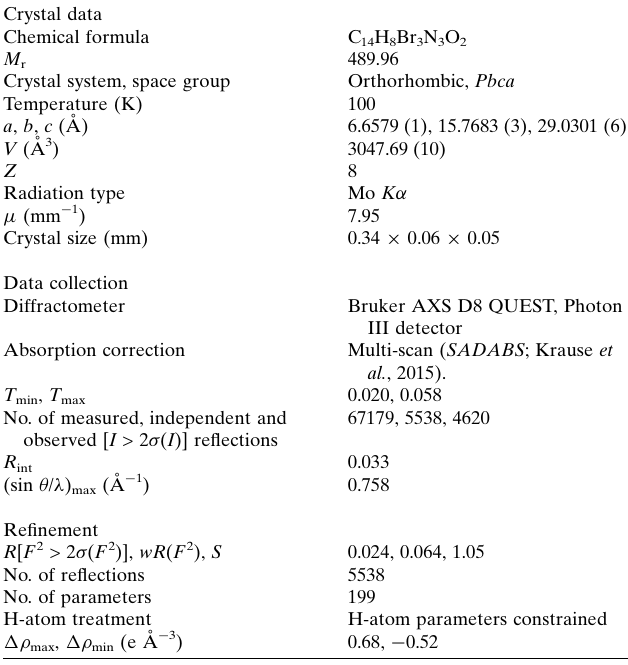
Table 3 Experimental